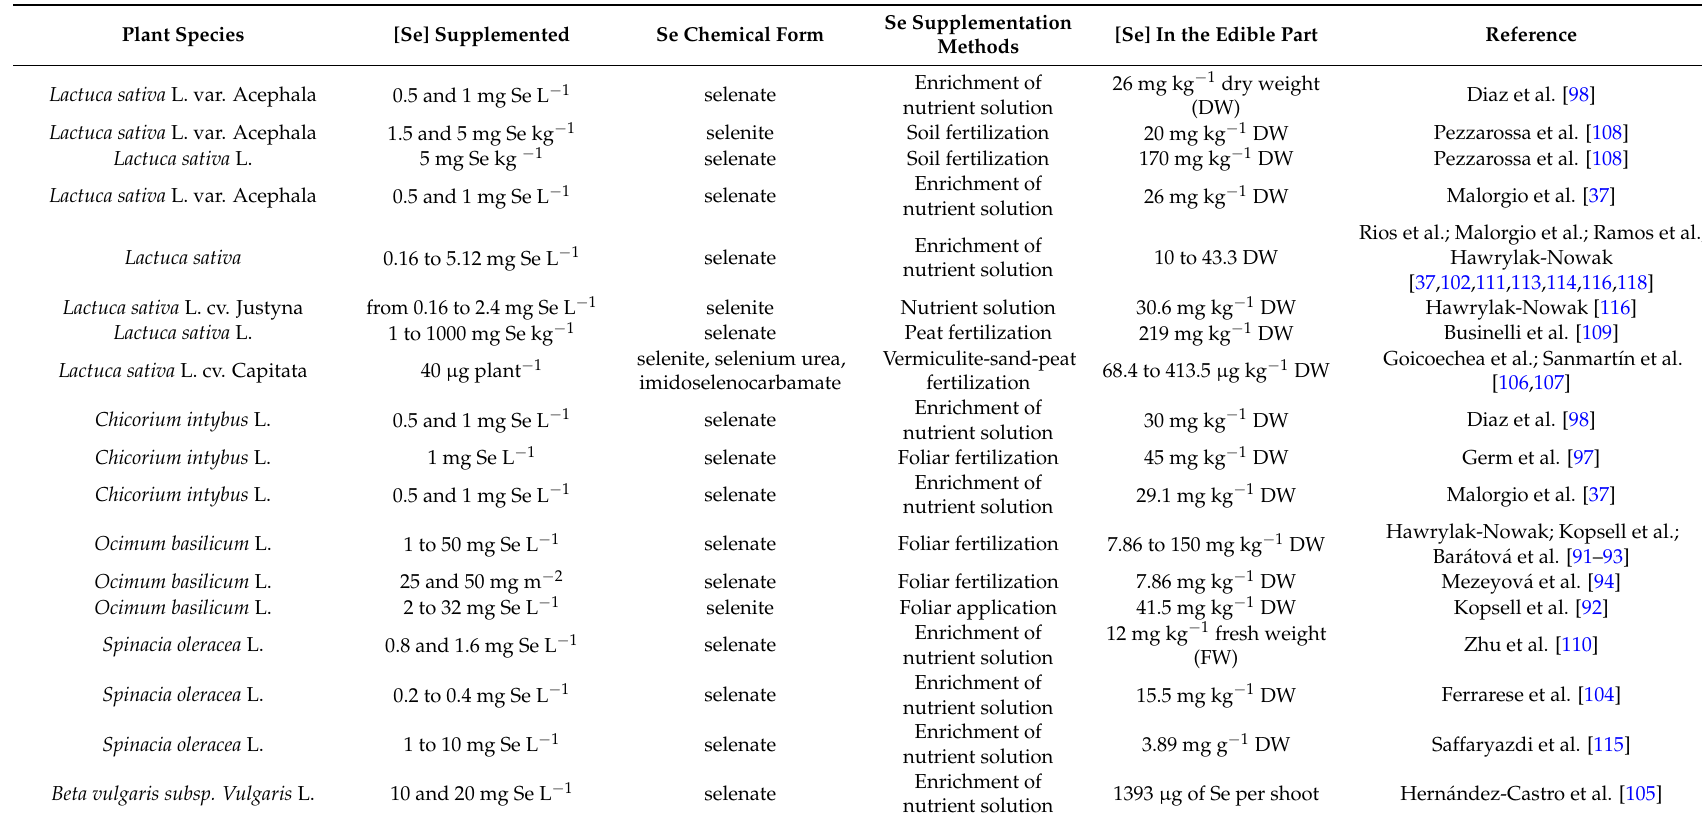
Table 1. Selenium (Se) accumulation in the edible parts of leafy vegetables in relation to the concentration, the chemical form of Se supplemented to plants, and the method of Se